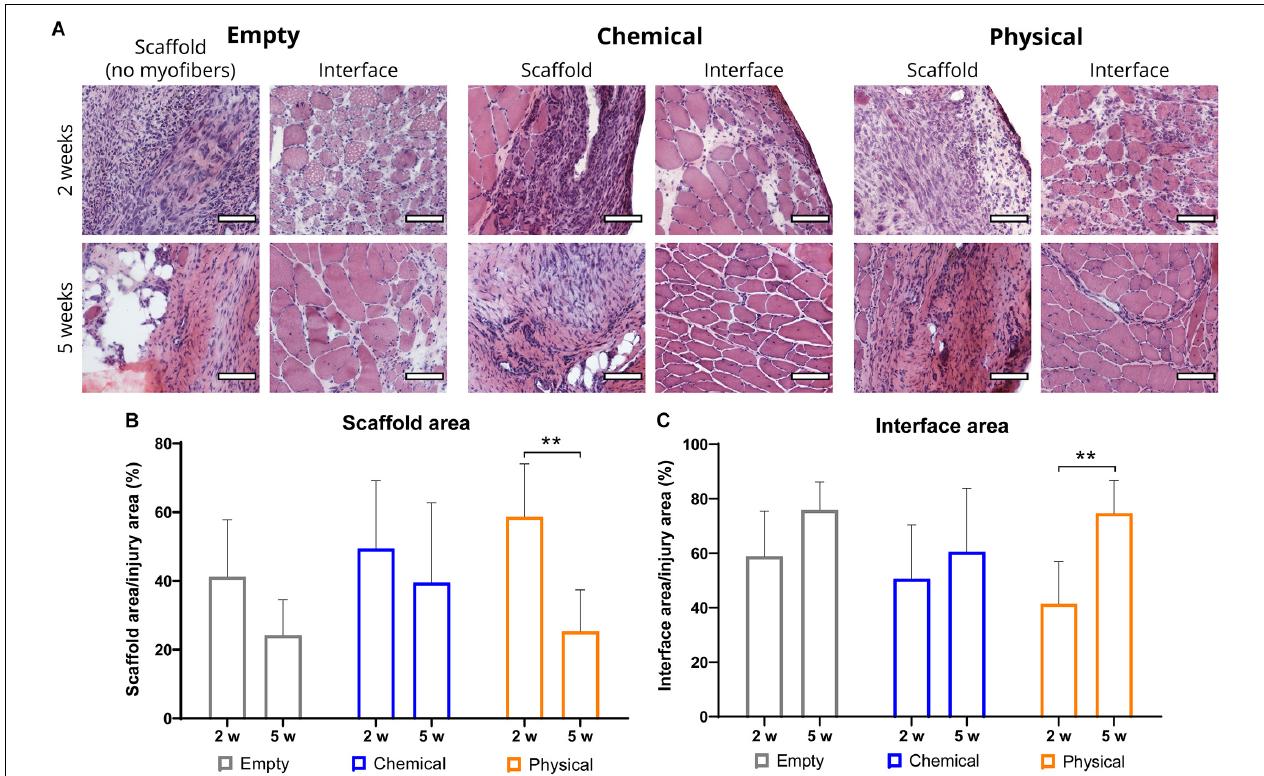
FIGURE 4 | (A) Representative images of the hematoxylin–eosin (HE) staining of sample cross-sections of the scaffold (area without newly formed myofibers) and interface (area with newly formed myofibers) regions (left and right for each group, respectively) of samples from the empty (left), chemical (center), and physical (right) groups at 2 (top) and 5 weeks (bottom) post-injury. Scale bar = 100 µ m. (B,C) Percentage of the interface and scaffold areas, with respect to the injury area at 2 and 5 weeks post-injury. ** p <